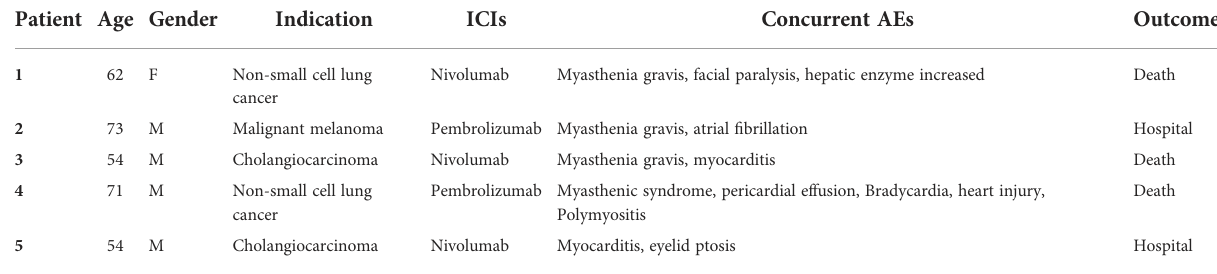
TABLE 3 ICI-related urinary continence concomitant with neuromuscular – cardiovascular syndrome case series in the FDA Adverse Event Reporting System database. Patient Age